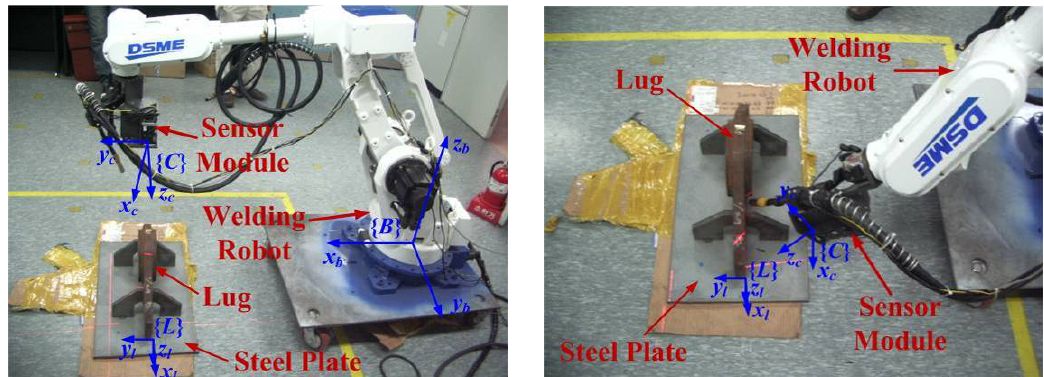
Figure 2. Possible robot configurations for the top and side view alignments.